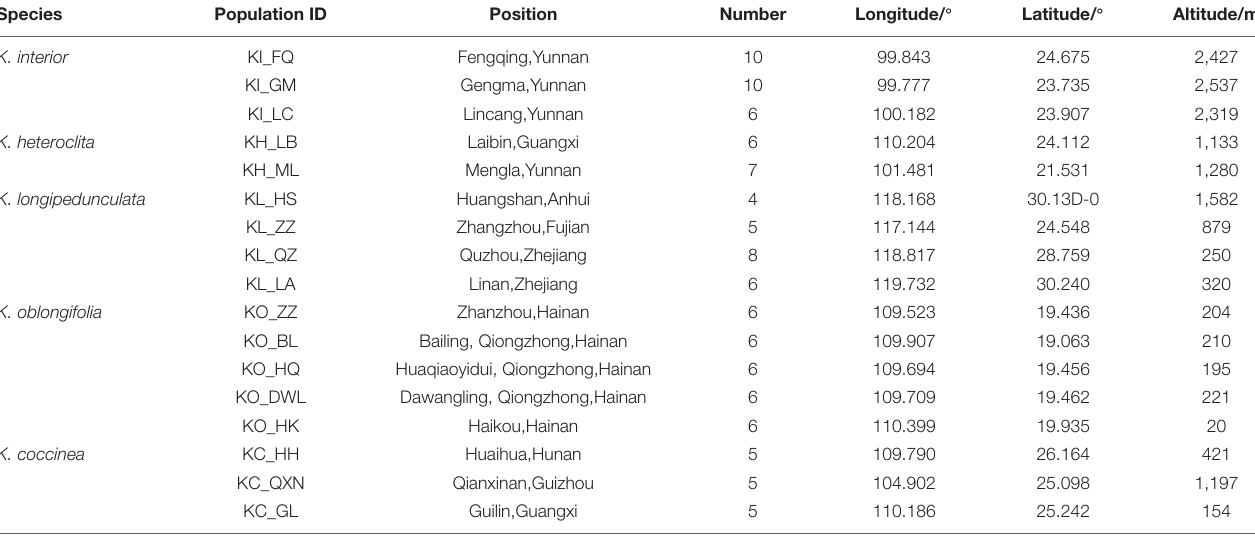
TABLE 1 | Sequencing sample information summary. Species